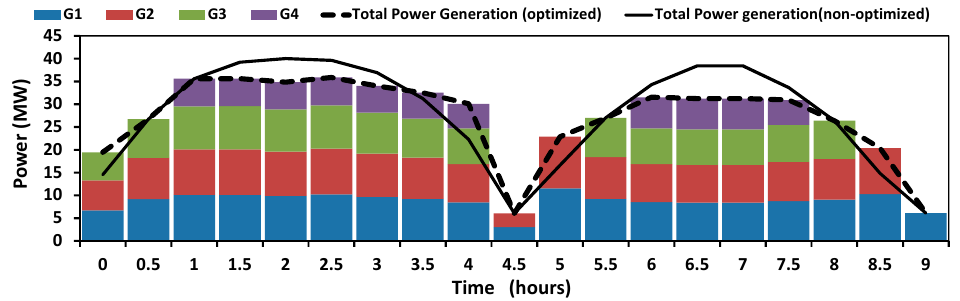
Figure 6. Optimal generator set power production, non-optimized ship electric load (DP-EEOI limited).